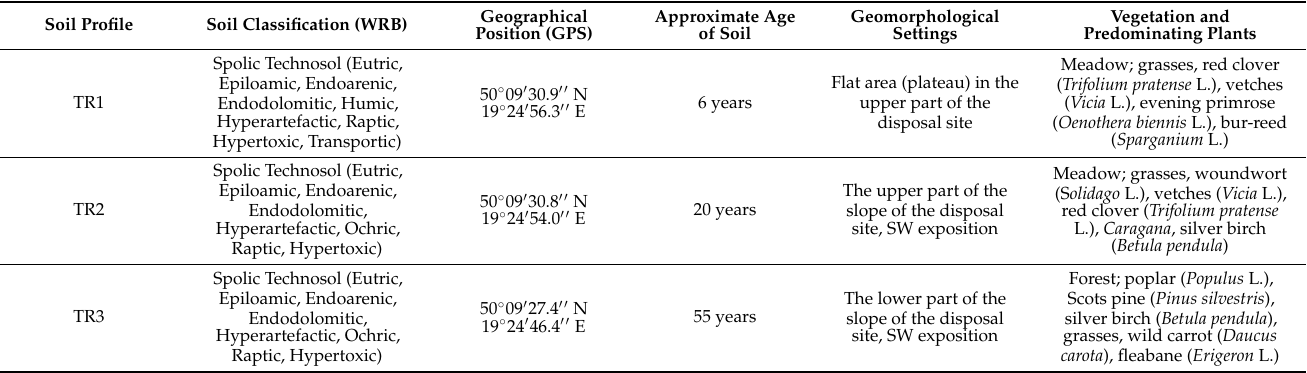
Table 1. Field description of the studied soil